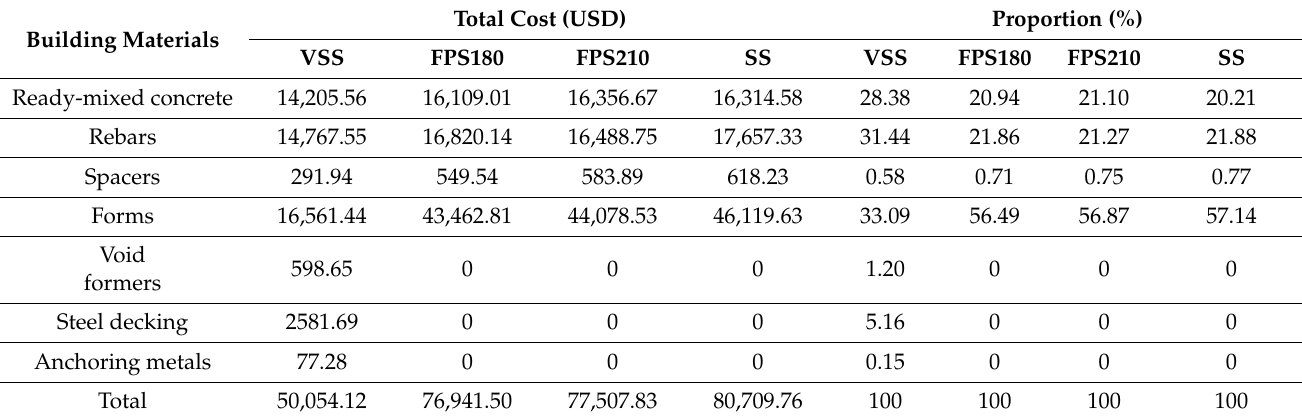
Table 6. Additional costs from the purchase of the building